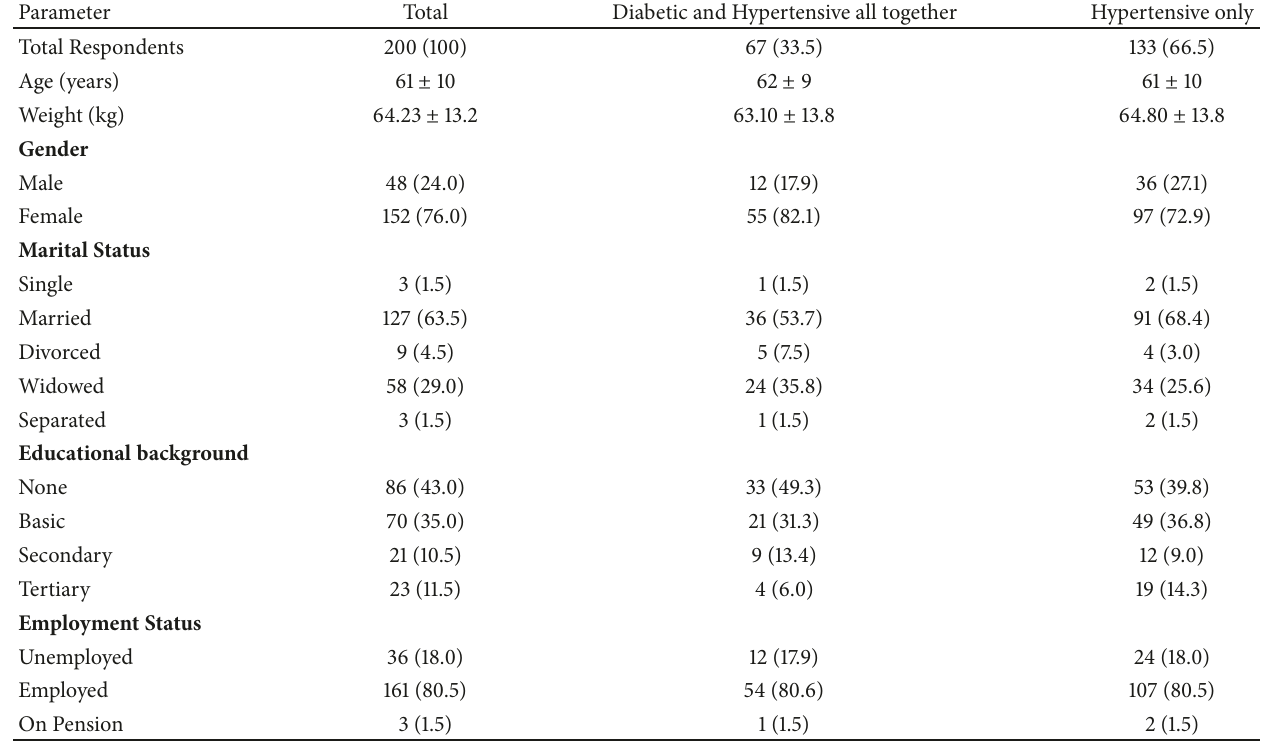
Table 3: Socio-demographic characteristic of the population under study stratified by disease status.